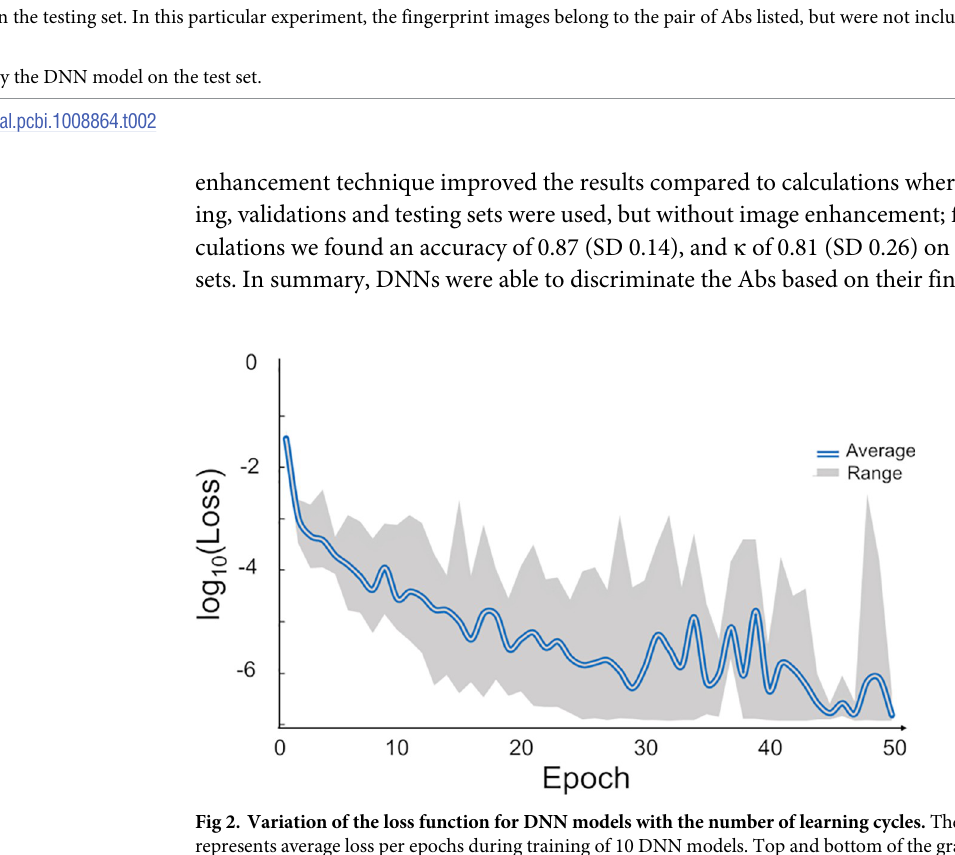
Fig 2. Variation of the loss function for DNN models with the number of learning cycles. The compound blue line represents average loss per epochs during training of 10 DNN models. Top and bottom of the gray area correspond to the maximum and minimum limits of the loss at each epoch for ten models. After about 30 epochs, there was no improvement in the loss function and we typically terminated the training at 30 epochs.